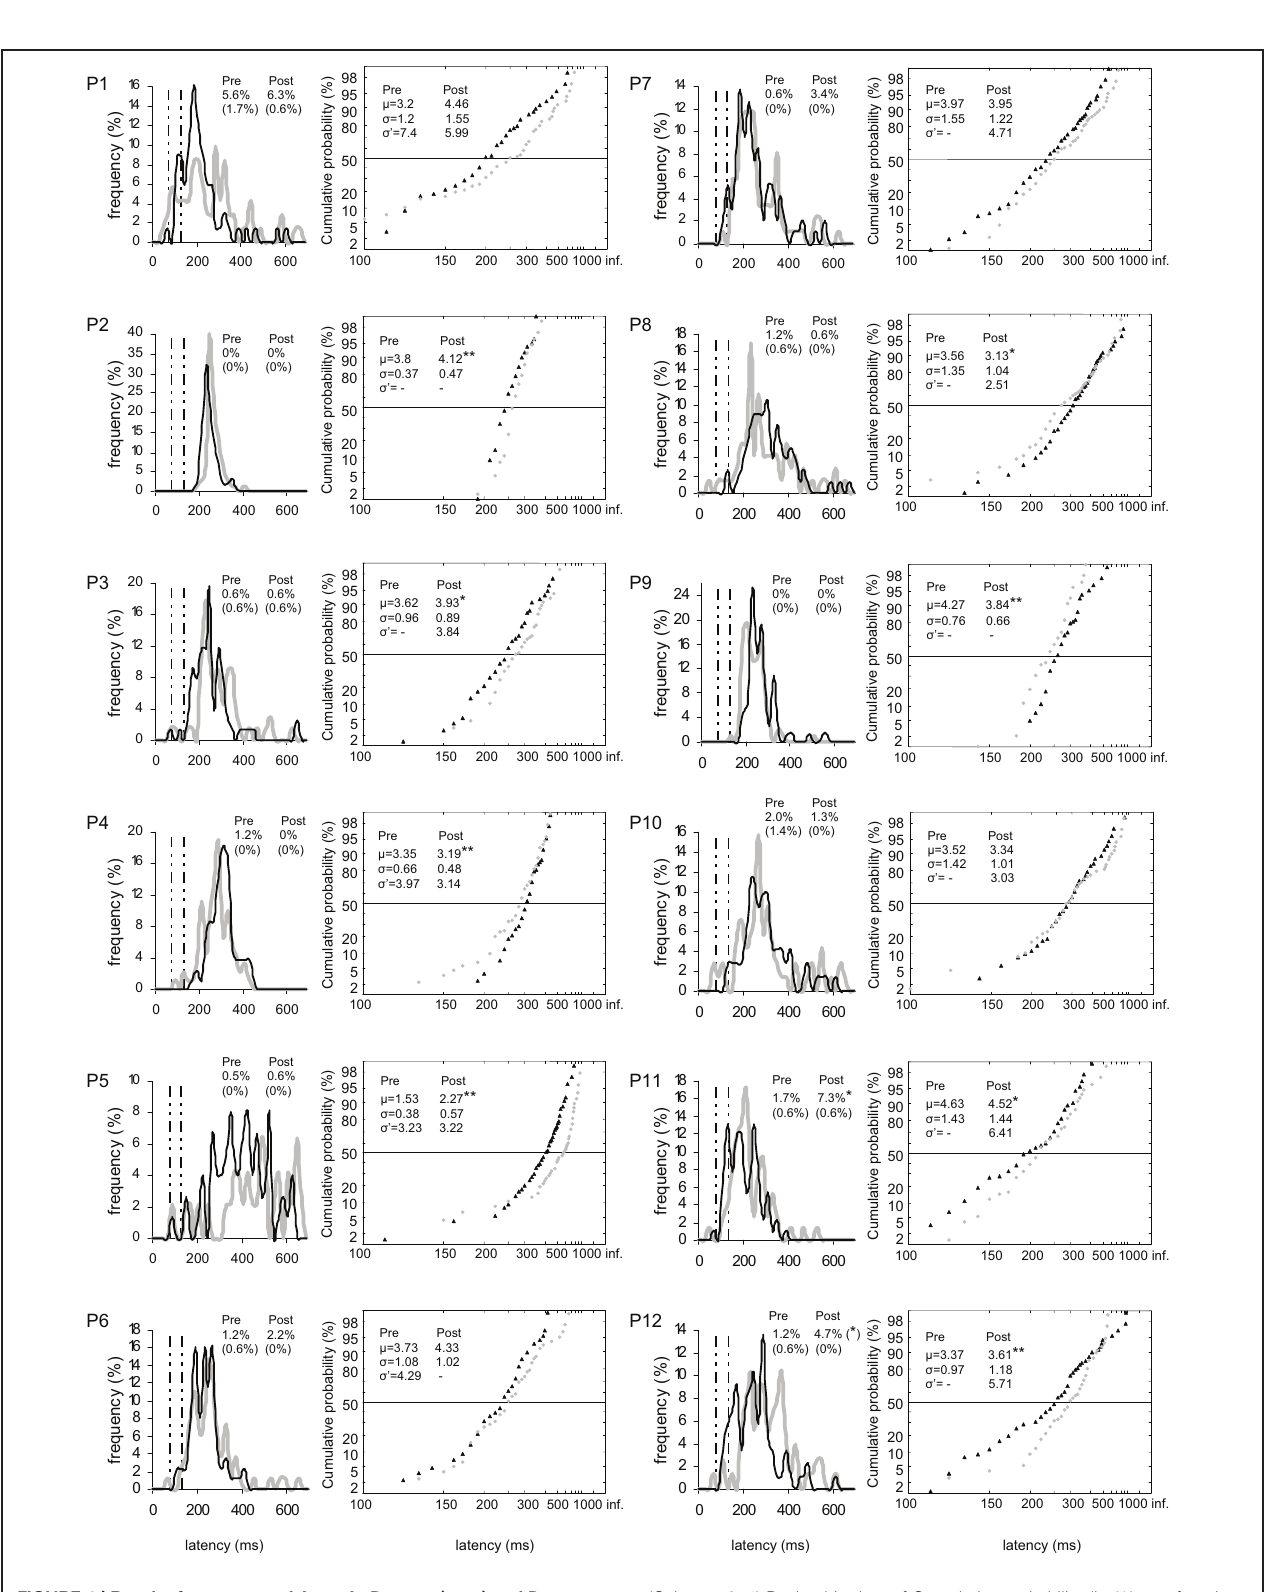
FIGURE 4 | Results for every participant in Pre-test (gray) and Post-test (black) periods for left target. (Columns 1, 3) Histograms of Frequency (in %) as a function of Latency (in ms) for saccades between 0 and 999ms in valid direction, and rates of express (Exp) and of anticipatory (Ant) saccades.